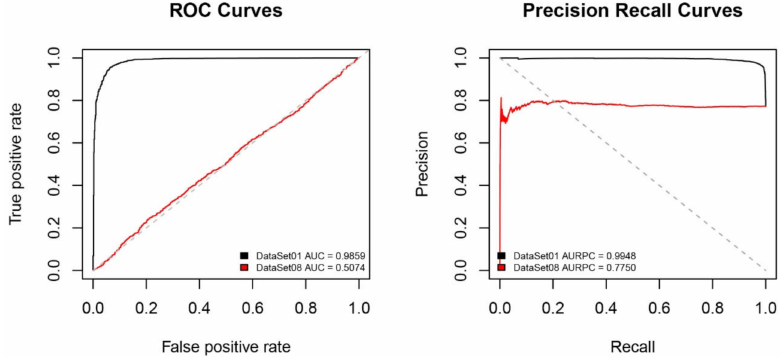
Figure 7. Recall-precision and ROC curves displaying the performance of LightGBM on testing datasets of DataSet 01 and DataSet